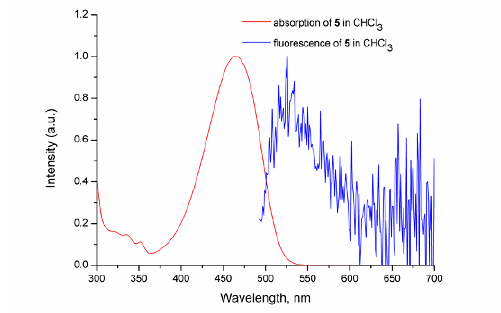
Figure 1. Absorbance and fluorescence spectra of 5 in CHCl